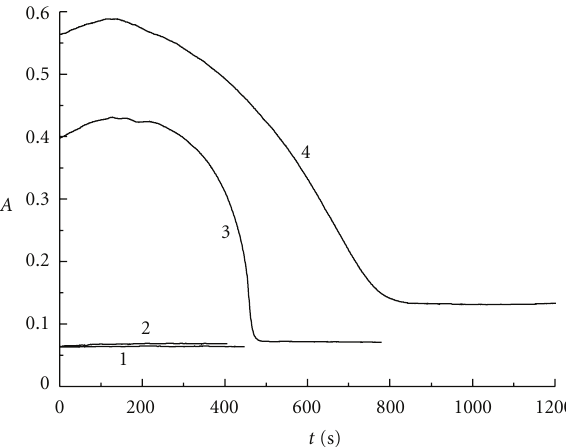
Figure 3: The absorbance versus reaction time at 297 nm for triiodide ion: curve 1: r = 2 . 03; curve 2: r = 3 . 00; curve 3: r = 3 . 95; curve 4: r = 4 . 85.